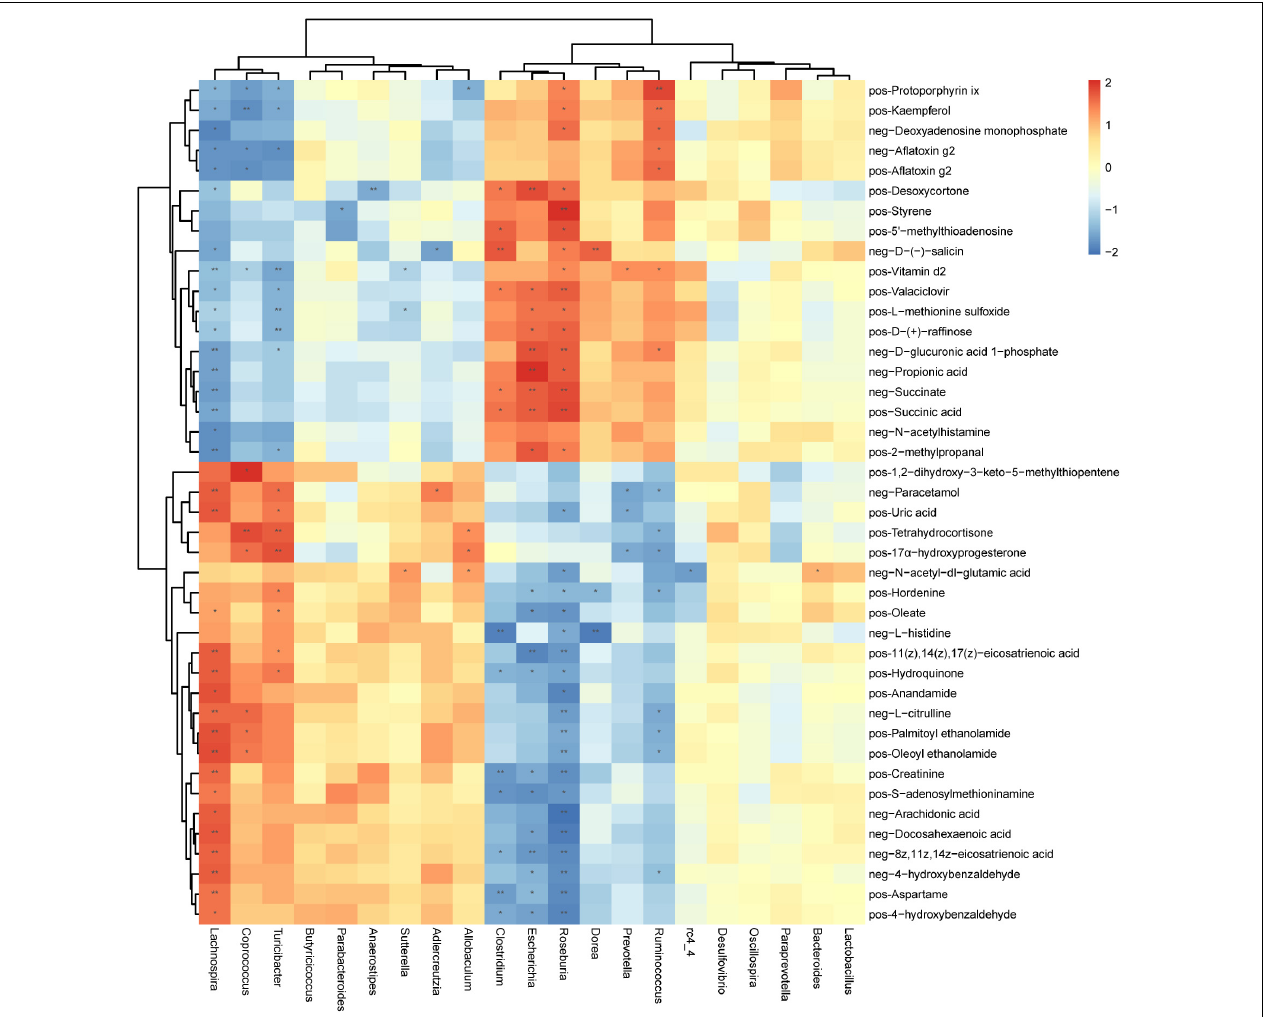
FIGURE 6 | Correlation between microorganisms (genus level) and metabolites in feces samples of periodontitis. Each row represents a metabolite and each column represents a genus. Each grid represents the correlation coefficient between a metabolite and a genus. Red is positive correlation, and blue is negative correlation. *( p < 0.05), **( p < 0.01) Significant correlation between the genera and metabolites. pos, positive ions; neg, negative